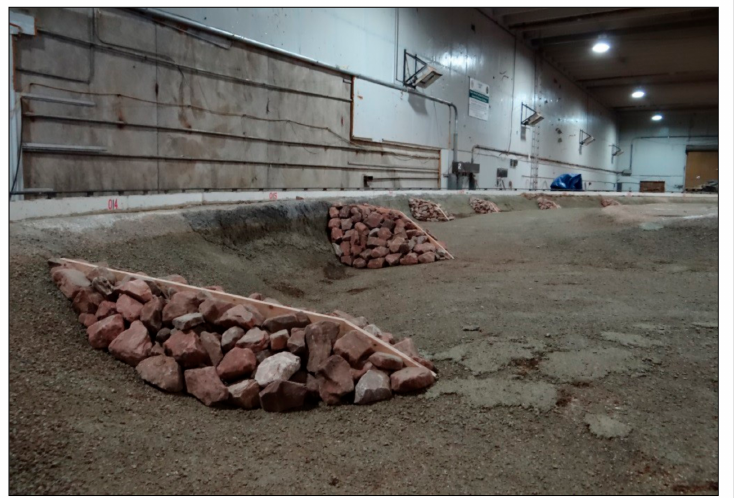
Figure 7. Constructed installation of rock vanes (looking downstream) [21]. Plywood in the center of each structure is used for